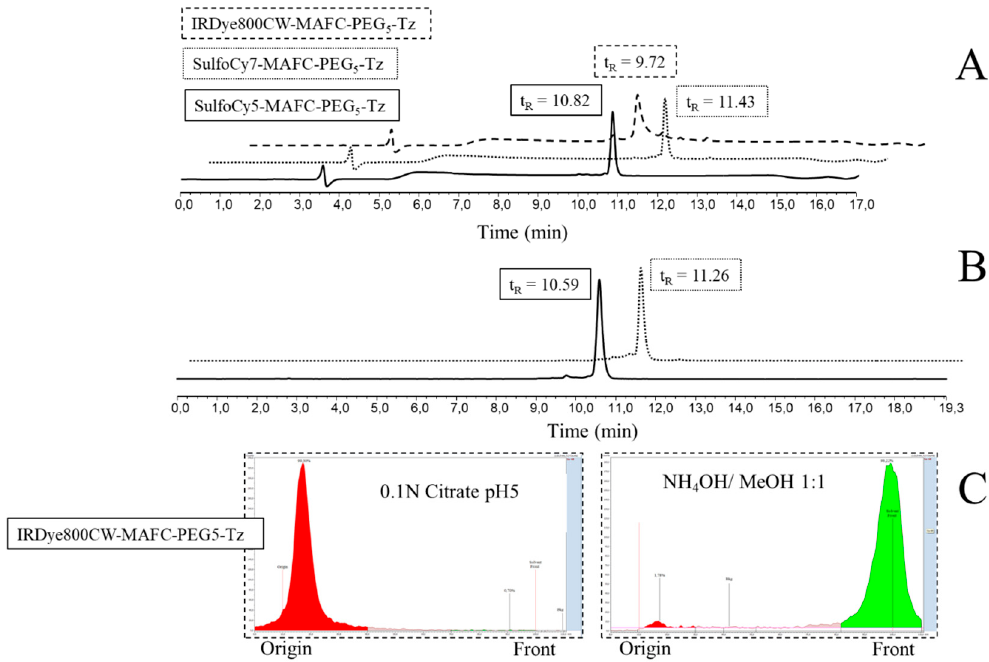
Figure 1. Representative chromatograms of monomeric FSC-based dual-modality imaging (DMI) agents. ( A ) shows UV-detection at λ = 220 nm, ( B ) represents radio detection of [ 68 Ga]Ga-SulfoCy5-MAFC-PEG 5 -Tz and [ 68 Ga]Ga-SulfoCy7-MAFC-PEG 5 -Tz, whereas ( C ) shows radio-ITLC (instant thin layer chromatography) analysis of [ 68 Ga]Ga-IRDye800CW-MAFC-PEG 5 -Tz using citrate (left) and ammonium acetate / ethanol (right) as mobile phase. Table 1. Distribution coe ffi cient (logD) and protein binding of 68 Ga-labeled FSC-based Tz-bearing hybrid imaging